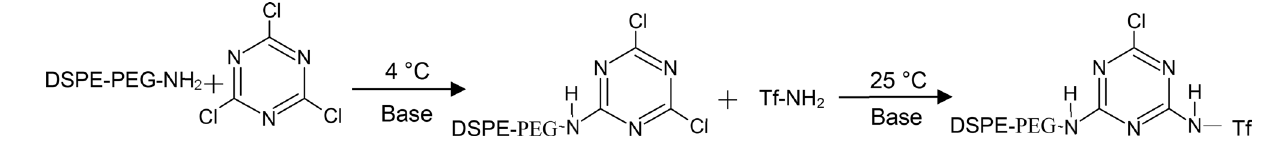
Figure 2. Transferrin (Tf) conjugation to the liposomes using cyanuric chloride as a coupling